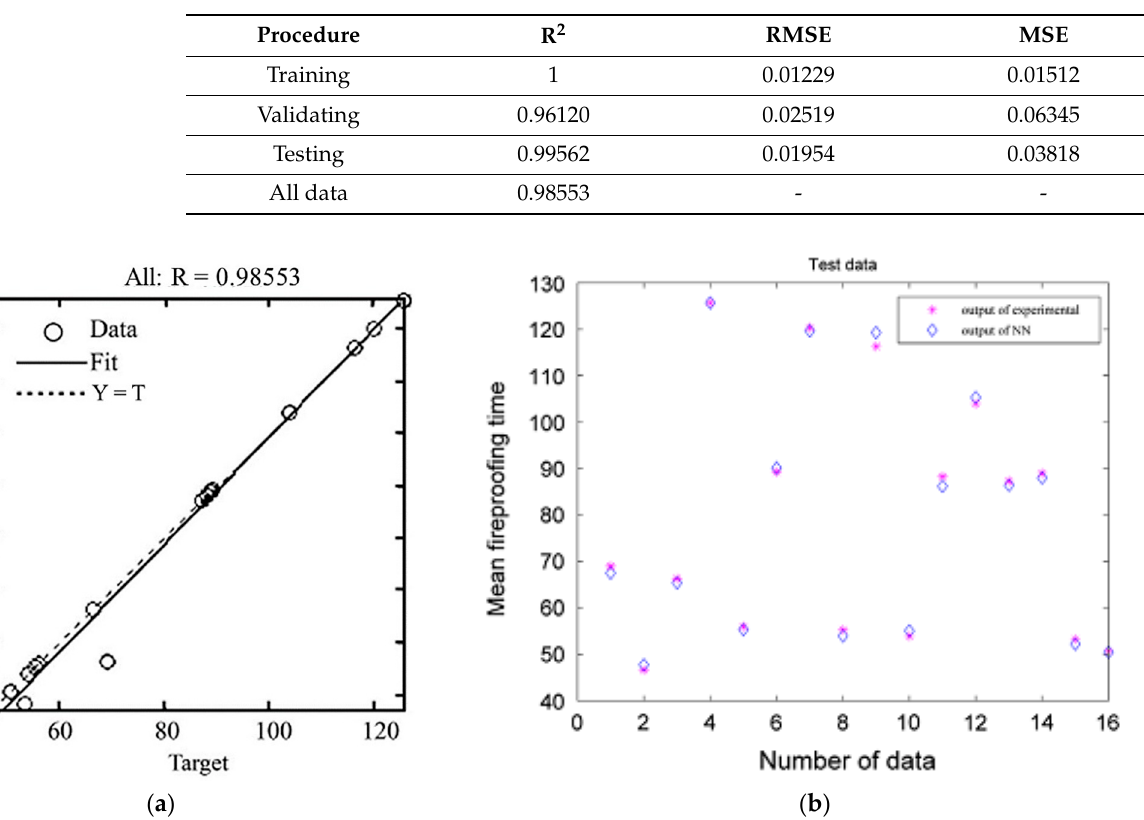
Table 3. The statistical metrics of the ANN model used to predict the mean fireproofing time of the intumescent flame-retardant coating [99].